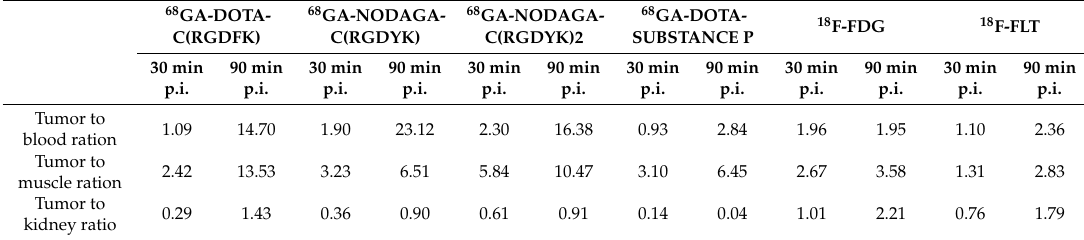
Table 2. Tumor to blood, tumor to muscle and tumor to kidney ratios calculated from ex vivo biodistribution data for four studied 68 Ga-peptides and two 18 F-tracers. Every tracer was evaluated at two times points of 30 min and 90 min post-injection. Data are presented as mean values (n = 3).